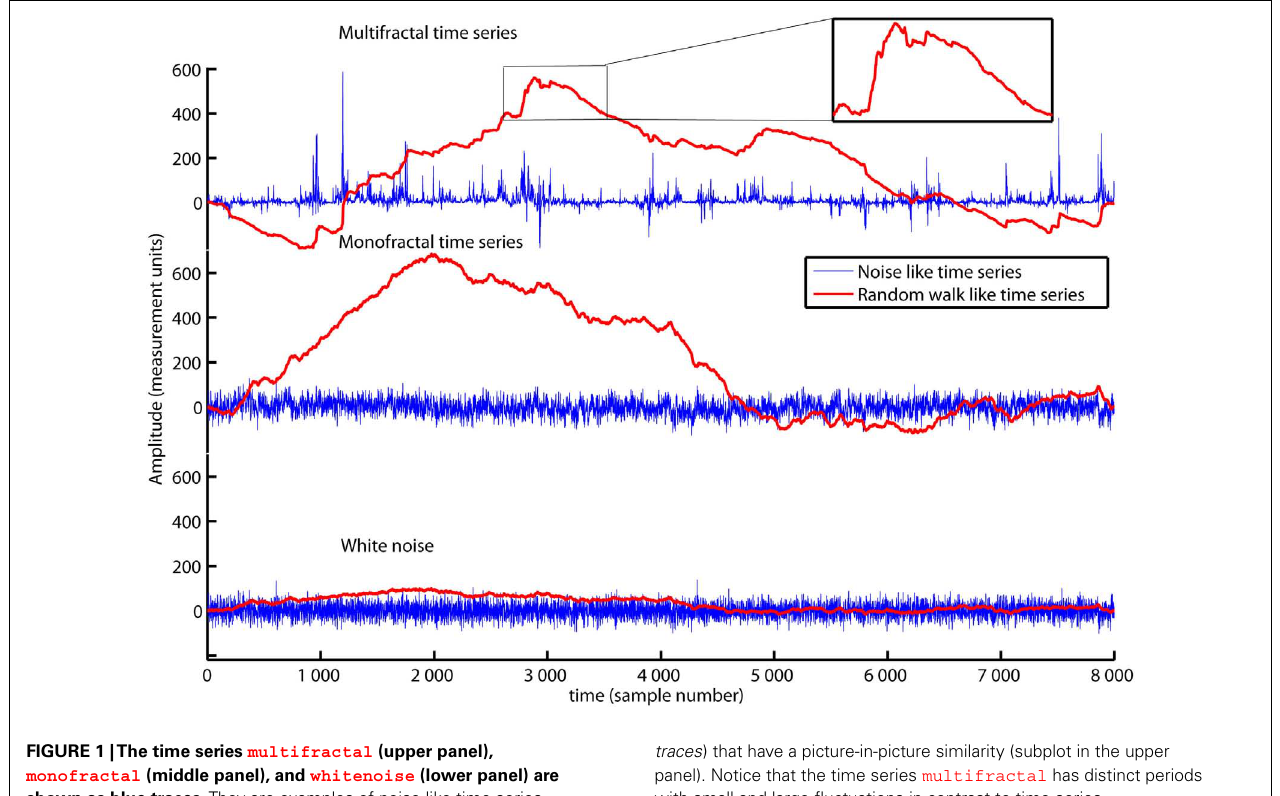
traces ) that have a picture-in-picture similarity (subplot in the upper panel). Notice that the time series multifractal has distinct periods with small and large fluctuations in contrast to time series monofractal and whitenoise .The aim of this section is to introduce MFDFA that quantify the structure of fluctuations within the periods with small and large